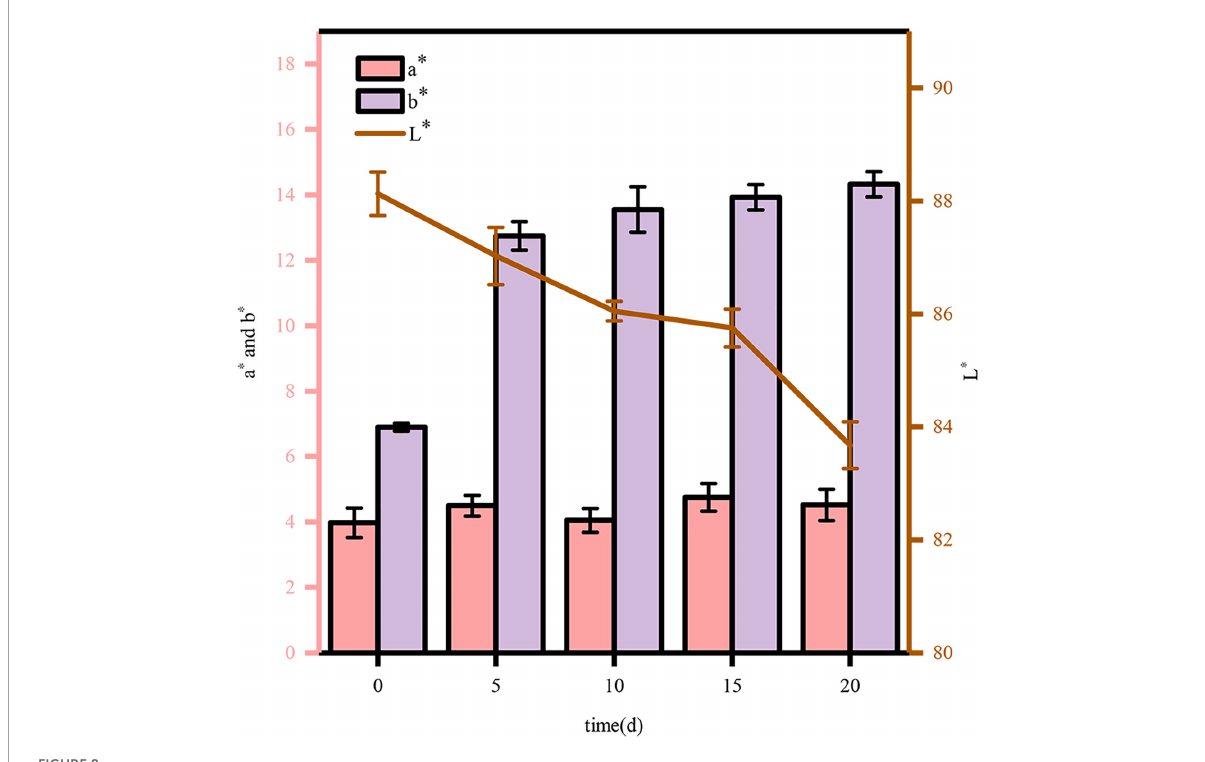
FIGURE8 Changes in color during COC